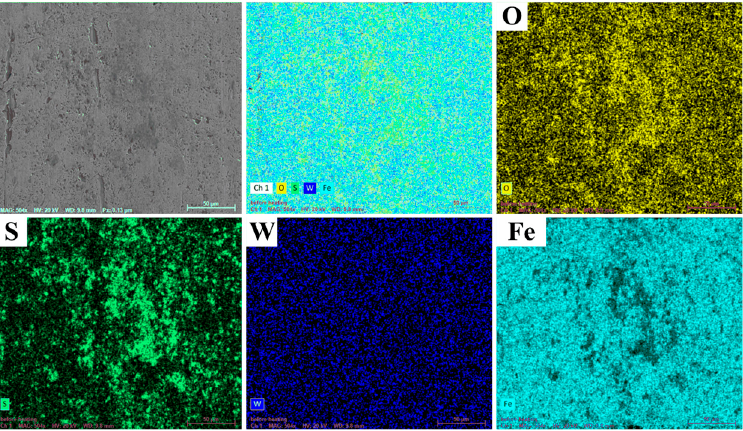
Figure 6. The EDS results of the worn surface of the TCW sample.